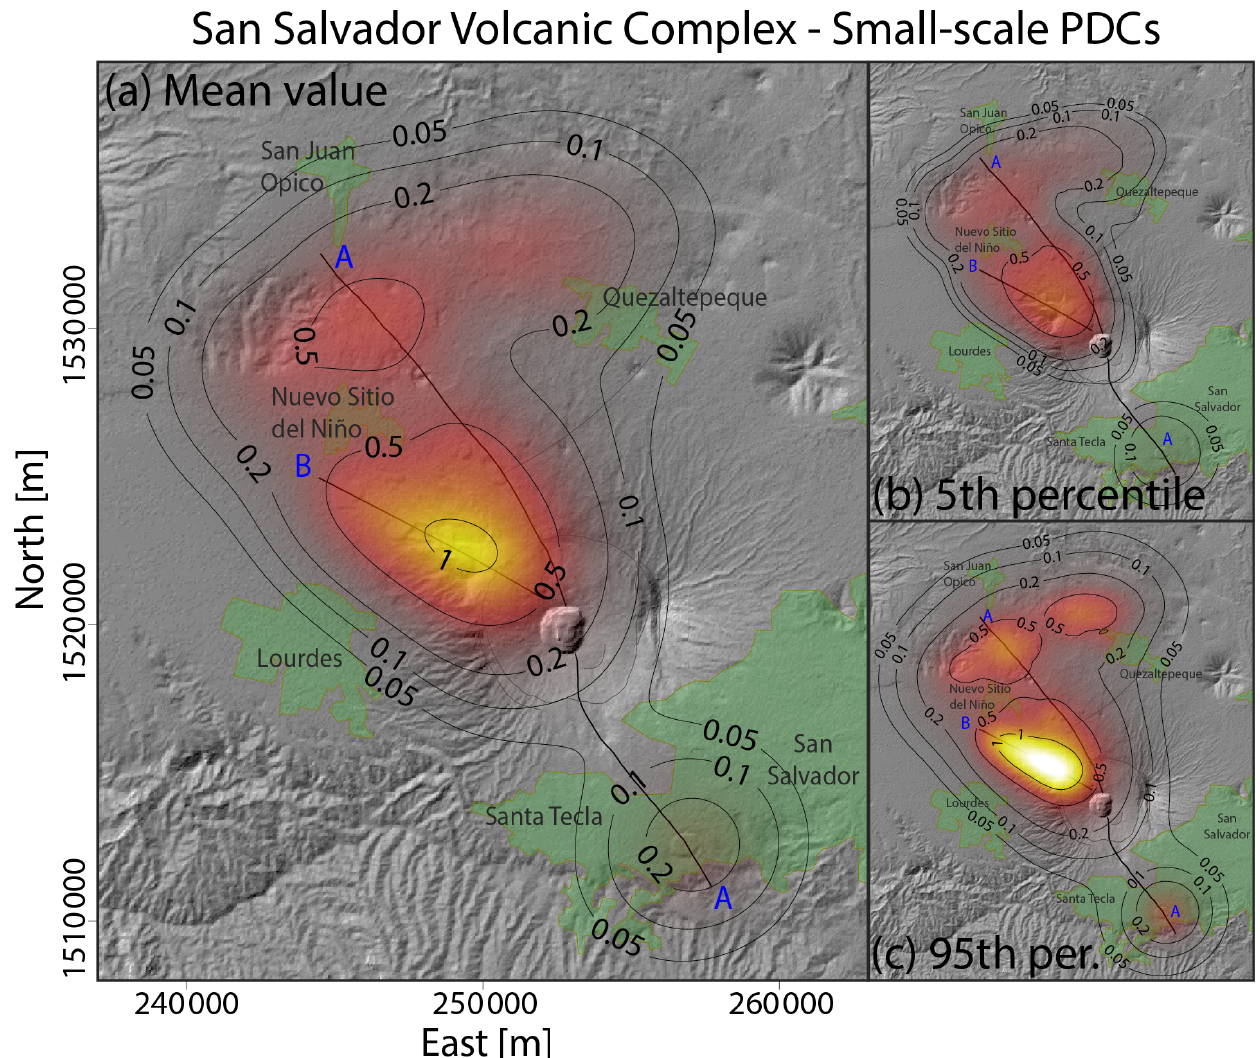
Figure 4. Density distribution of the probability of vent opening at the San Salvador volcanic complex associated with the occurrence of volcanic activity able to produce small-scale pyroclastic density currents. (a) Mean value. (b) 5th percentile. (c) 95th percentile. Results are expressed in percentage per km 2